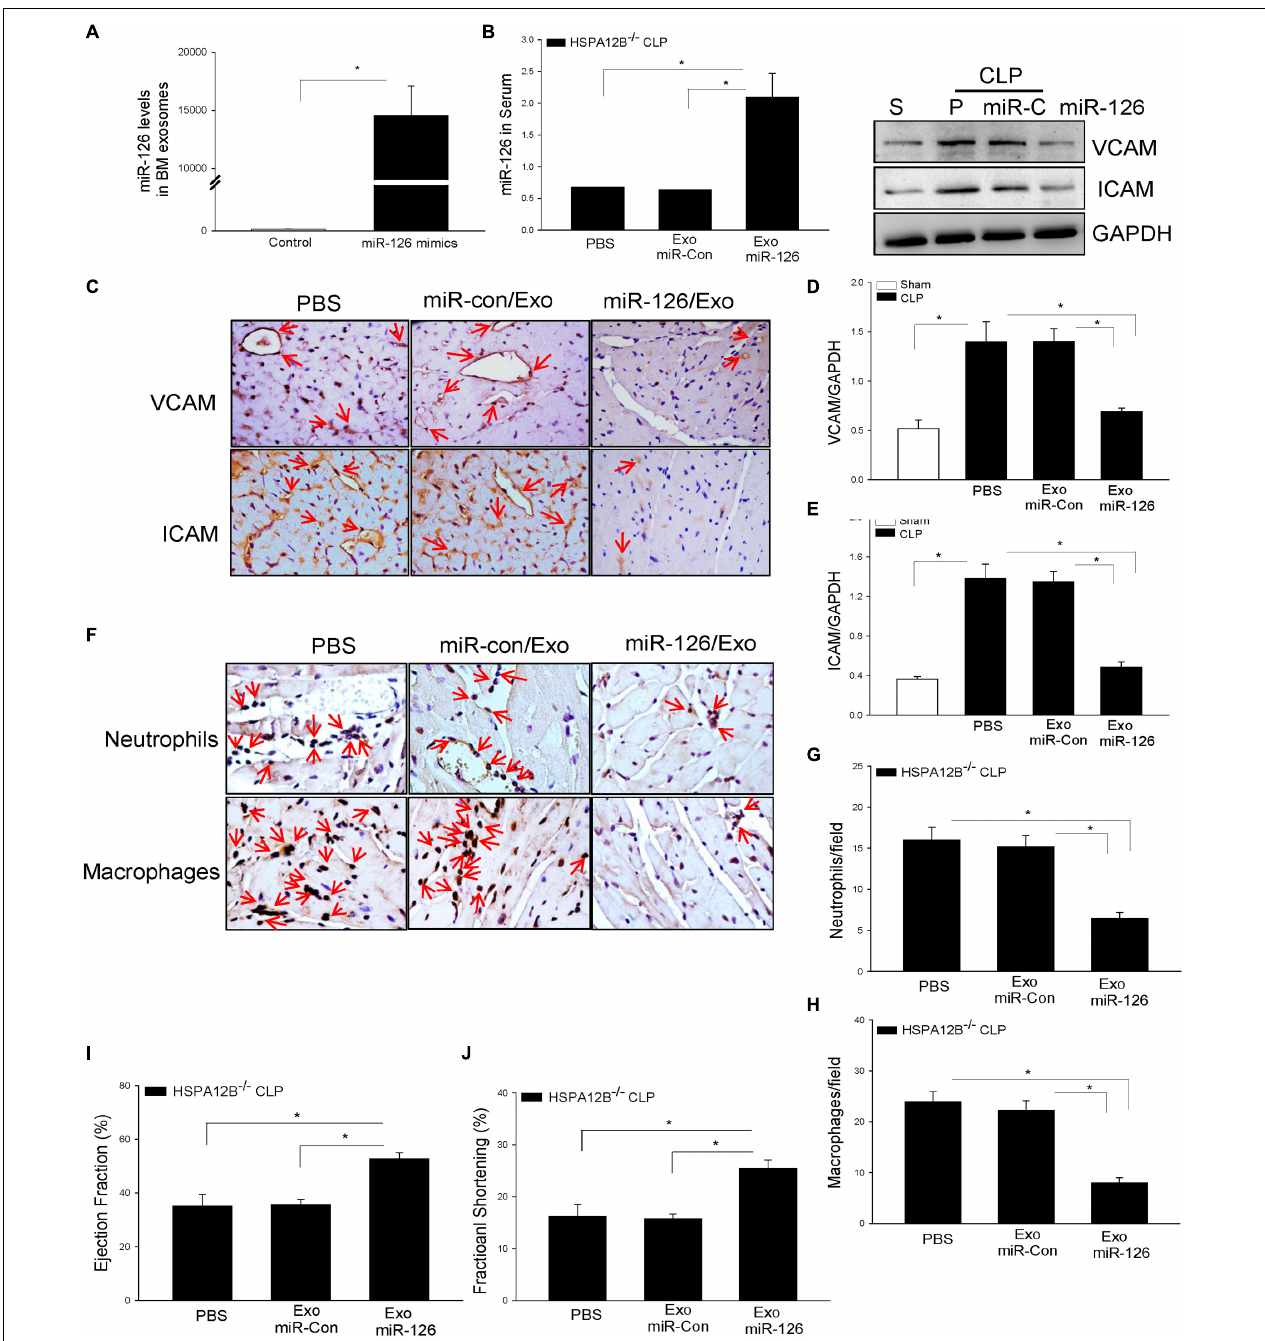
FIGURE 6 | MicroRNA-126 carried by exosomes derived from bone marrow stromal cells suppressed adhesion molecule expression in the myocardium of HSPA12B − / − septic mice. Bone marrow stromal cells (BMSCs) were isolated from HSPA12B − / − mice and transfected with 40 nmol/L scrambled miR-control or miR-126 mimics at the fourth to seventh generation. Twenty-four hours after transfection, exosomes were isolated from supernatants. (A) The levels of miR-126 in exosomes were examined qPCR. (B) HSPA12B − / − mice were transfected with exosomes loaded with miR-126 mimic or scrambled miR-control through the right carotid artery immediately before induction of CLP sepsis. Serum miR-126 levels were examined by qPCR 6 h after CLP. (C) VCAM-1 and ICAM1 expressions in the heart tissues were examined by immunohistochemistry staining with anti–VCAM-1 and anti–ICAM-1 antibodies. (D,E) Western blot analysis of VCAM-1 and ICAM1 levels in the myocardium of HSP12B − / − septic mice ( n = 6–9/group). (F) The accumulation of neutrophils and macrophages in the myocardium was examined by immunohistochemistry with antineutrophil elastase antibody and antimacrophage antibody F4/80. (G,H) miR-126 carried by exosomes decreased the numbers of neutrophils (G) and macrophages (H) in the myocardium of HSPA12B − / − septic mice. (I,J) miR-126 carried by exosomes improves cardiac function (EF %, FS %) measured by echocardiography. n = 6–9/group for Western blot and n = 3/group for immunohistochemistry. * P < 0.05 compared with indicated groups. The immunohistochemistry staining was examined with bright field microscope (40 ×